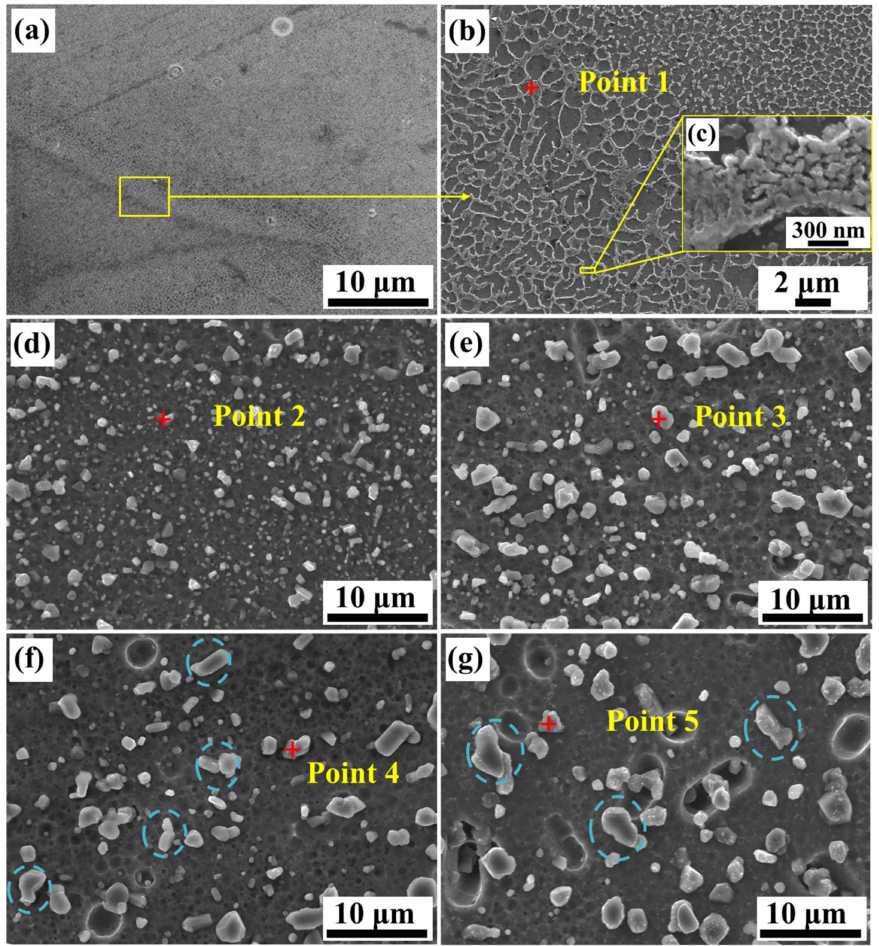
Figure 4. The SEM micrographs of the SLM fabricated AlSi10Mg alloy under different conditions: ( a ) the overlap profile of the molten pool of Alloy A, ( b ) the magnification of Alloy A in ( a ), ( c ) further magnification of networked eutectic silicon of Alloy A, ( d ) Alloy B ( e ) Alloy C, ( f ) Alloy D, ( g ) Alloy E. Table 4. The EDS point scan analysis results of the typical positions in Figure 4 (at. %). Point